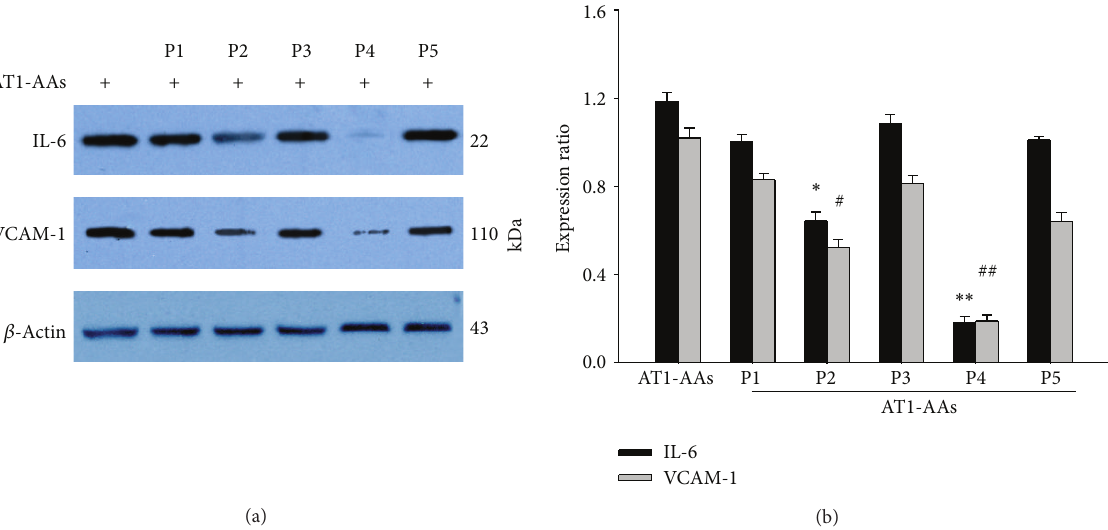
Figure 9: Effects of five short peptides on AT1-AAs-induced IL-6 and VCAM-1 expression in endothelial cells. The short peptides were added to cells medium 2 hours before AT1-AAs treatment for 12 hours. And the IL-6 and VCAM-1 expression were determined by Western blot (panel (a)). The five short peptides were P1, VFFIEN; P2, ENTNIT; P3, ITVCAF; P4, AFHYESQ; P5, QNSTLPI. Data were summarized from 5 independent experiments (panel (b)); ∗ 𝑃 < 0.05 versus AT1-AAs (control) group, IL-6 expression; # 𝑃 < 0.05 versus AT1-AAs (control) group, VCAM-1